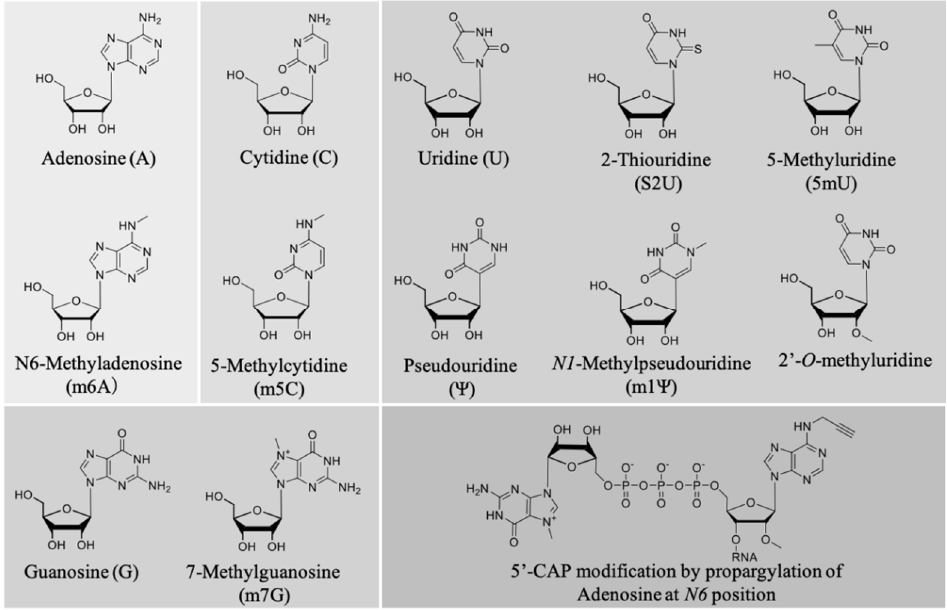
Figure 5. Commonly adapted chemical modifications in mRNA